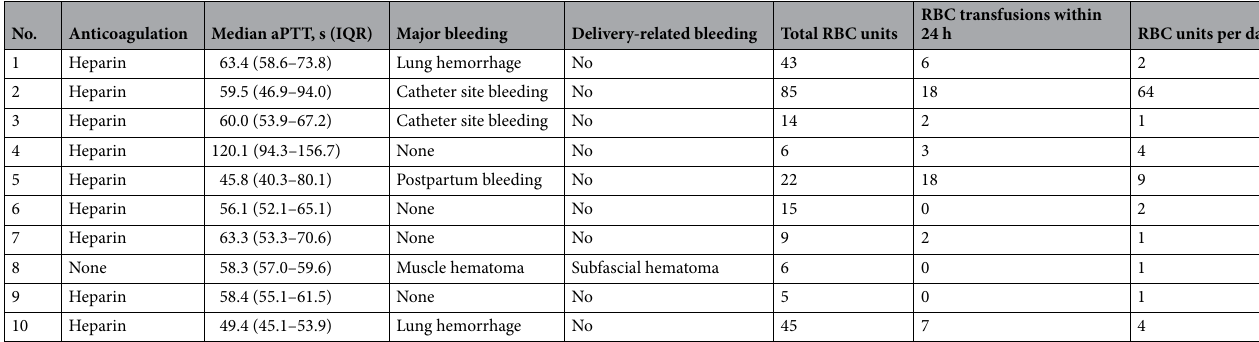
Table 2. Bleeding results during ECMO. ECMO extracorporeal membrane oxygenation, aPTT activated partial thromboplastin time, IQR interquartile range, RBC red blood cell.